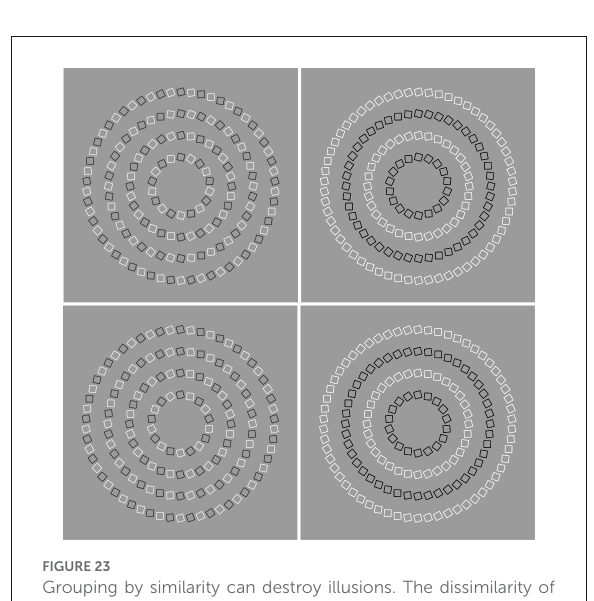
FIGURE23 Grouping by similarity can destroy illusions. The dissimilarity of the checks on the left shows respectively a double intertwined spiral and a spiral (first column). These phenomena almost disappear when the similarity groups the elements highlighting the concentric rings of slightly tilted